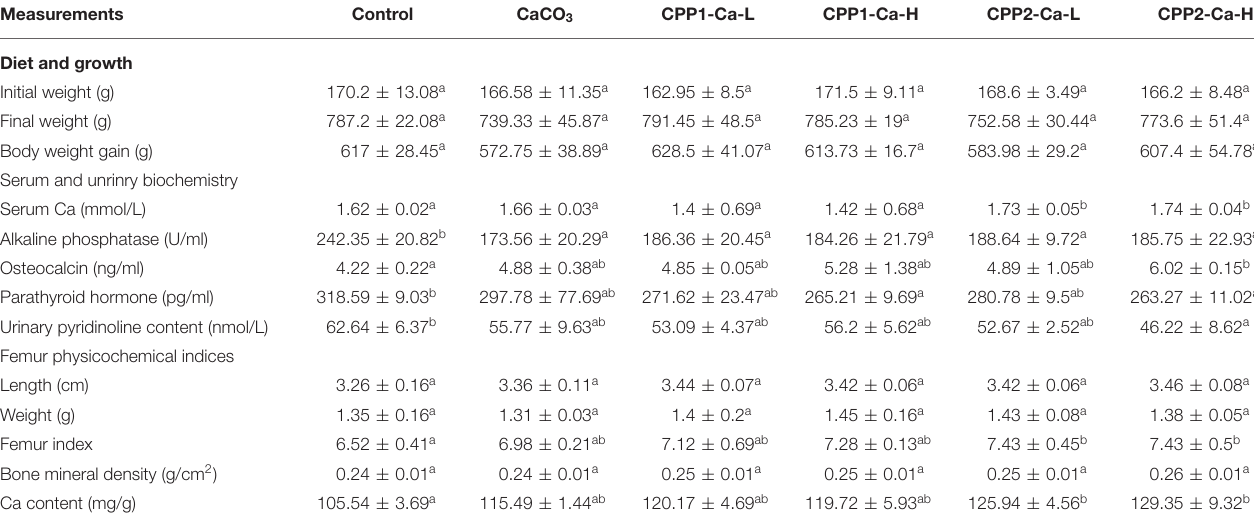
TABLE 3 | Growth, femur, and biochemistry properties of rats after different treatments.